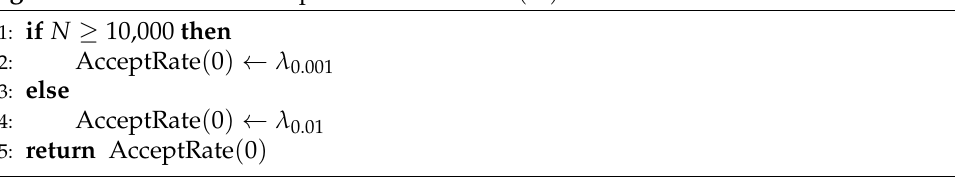
Algorithm 5 TuneInitialAcceptanceRateEstimate ( N )